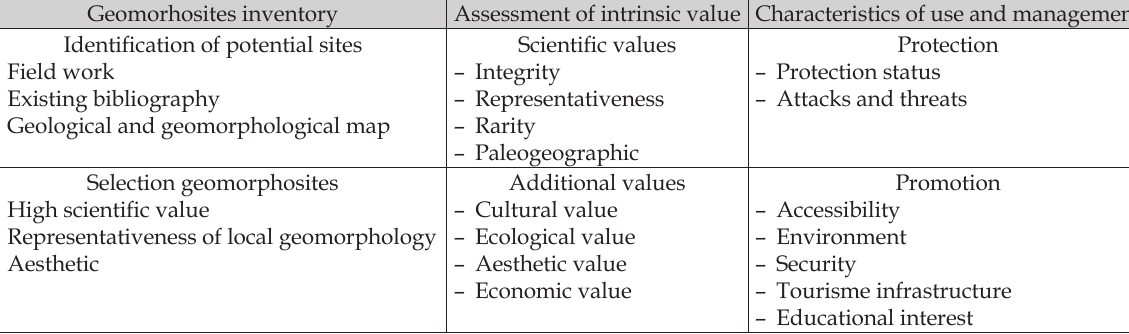
Table 1. Methodology used (based on reynard et al.